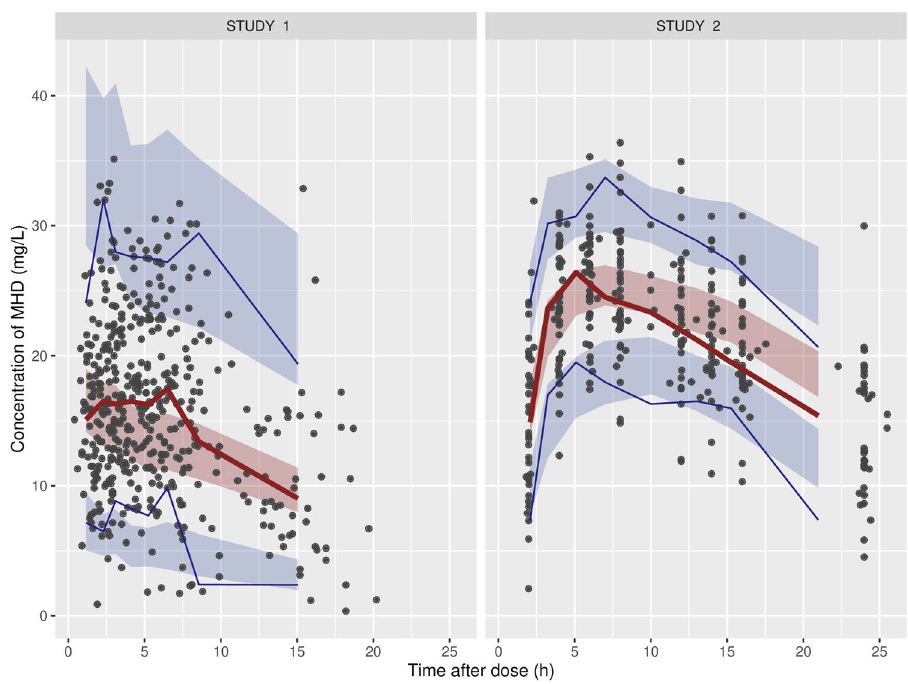
Figure 1. Visual predictive check for MHD. The shaded areas represent the 5th, 50th and 95th percentiles of simulated data (n = 1000). The solid lines are the median along with the 5th and 95th percentiles of the observed data (n = 1000). The left panel shows the results for Study 1, and the right panel shows the results for Study 2. Study 1 – Epilepsy Registry Cohort; Study 2 – Sigle dose study of